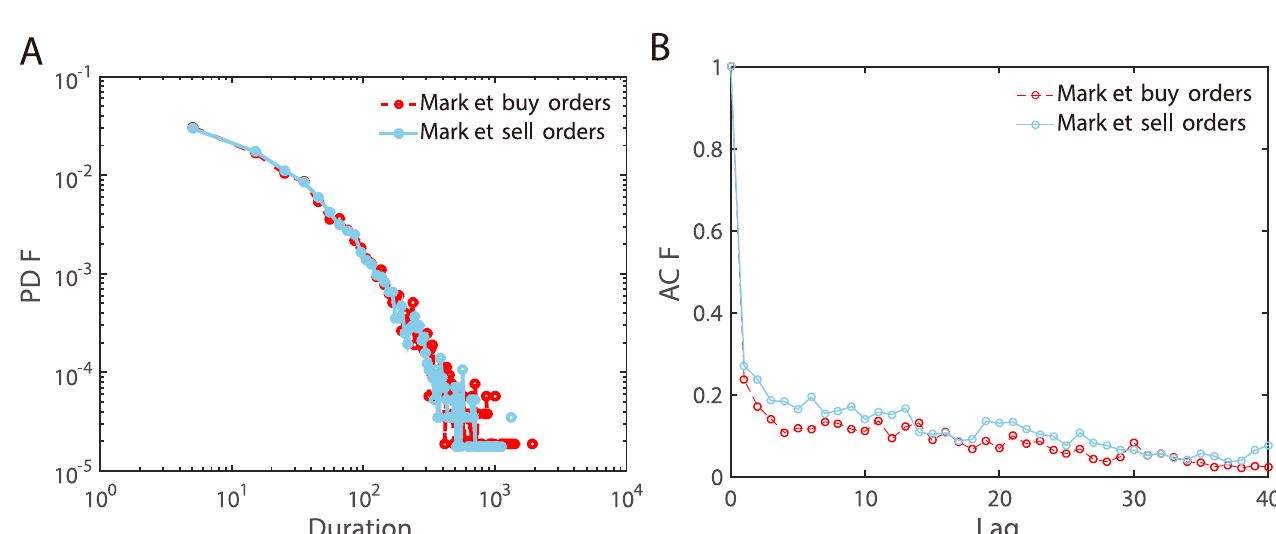
PLOS ONE | https://doi.org/10.1371/journal.pone.0226667 January 10,